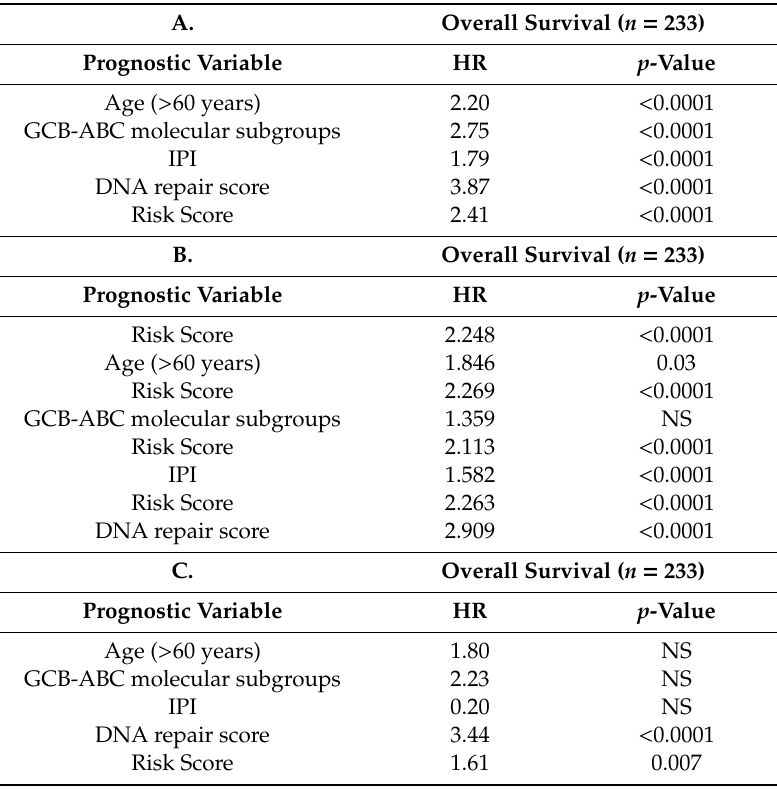
Table 1. Cox univariate and multivariate analyses of prognostic factors of overall survival in patients with di ff use large B-cell lymphoma (R-CHOP Lenz cohort, n = 233). A. Overall Survival ( n =